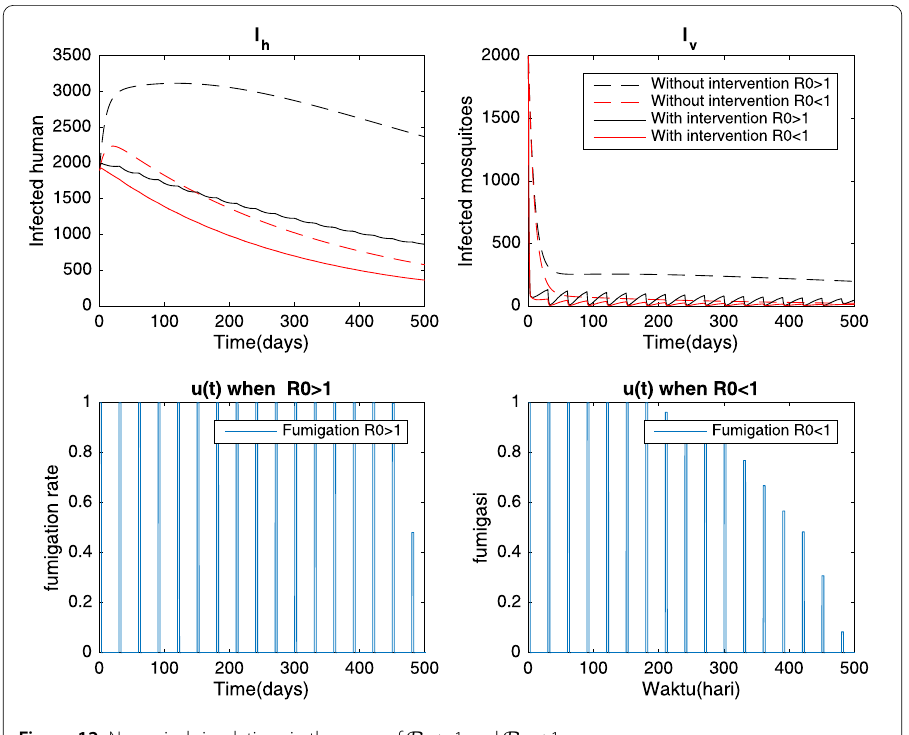
Figure 12 Numerical simulations in the cases of R 0 > 1 and R 0 < 1